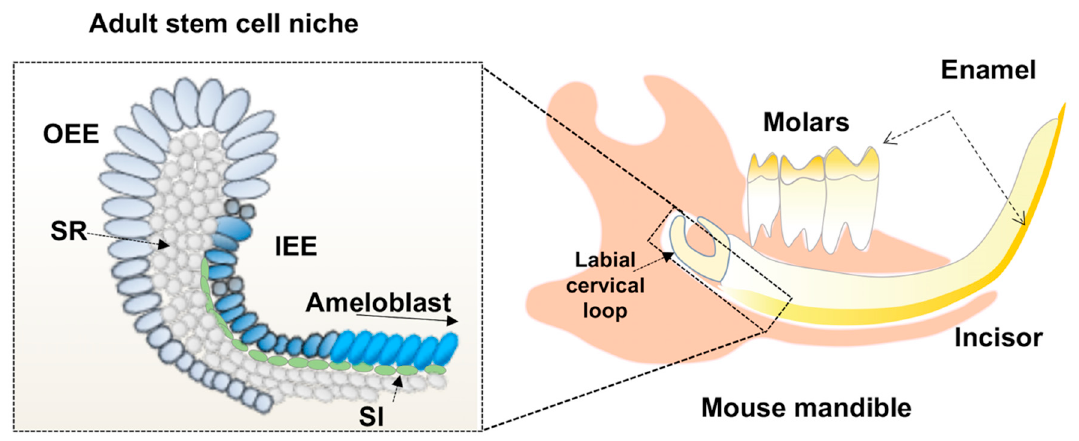
Figure 1. A diagram to show the location of adult stem cell niche in mouse mandible, where stem cells (SC) and di ff erent type of dental epithelia reside such as outer and inner enamel epithelia (OEE, IEE), the stellate reticulum (SR), and the stratum intermedium (SI). The IEE are di ff erentiated into ameloblast through sequential steps and generate enamel on the tooth.